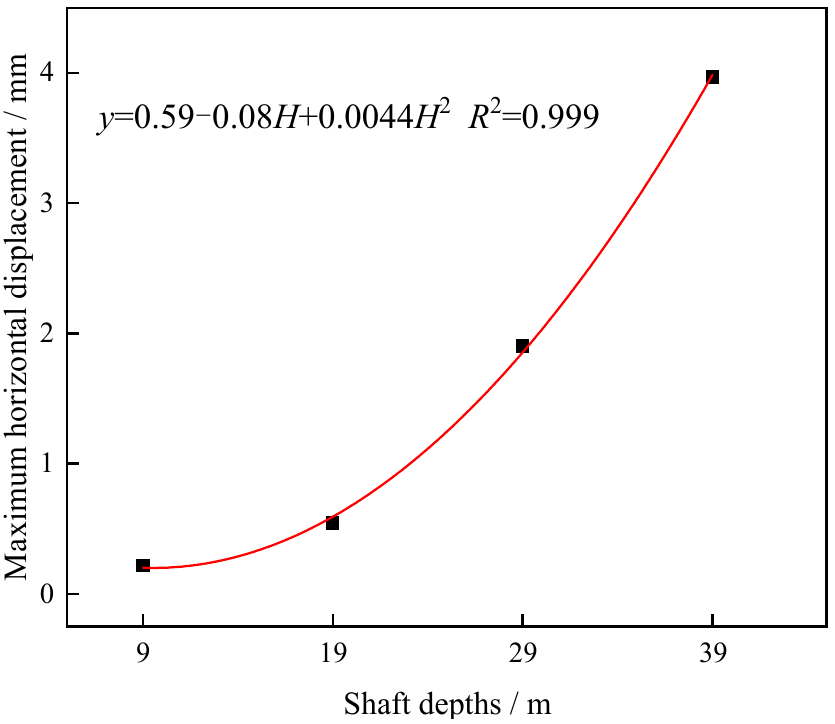
Figure 21. Relationship between maximum horizontal displacement and shaft depth.